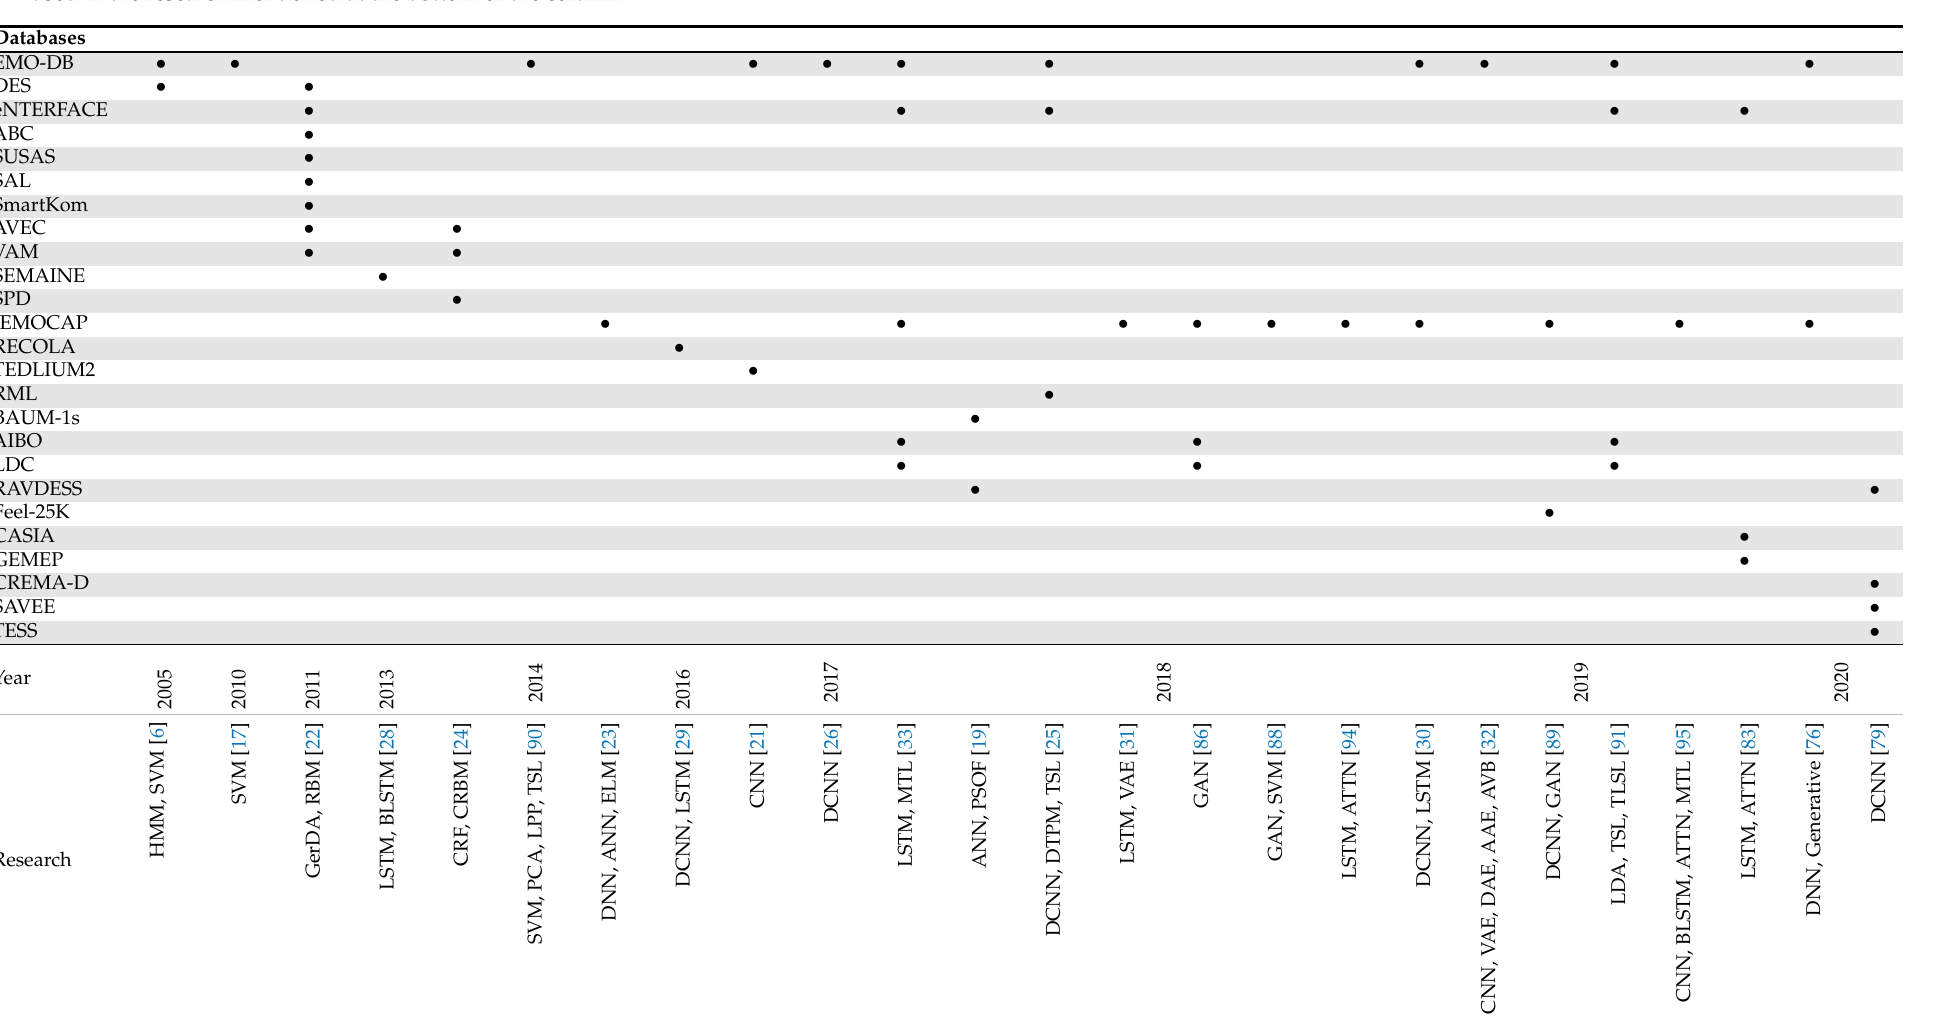
Table 3. A concise comparison between all the reviewed deep learning methods sorted by year and the databases used. A black dot ( • ) in a cell means the corresponding database was used in the research mentioned at the bottom of the